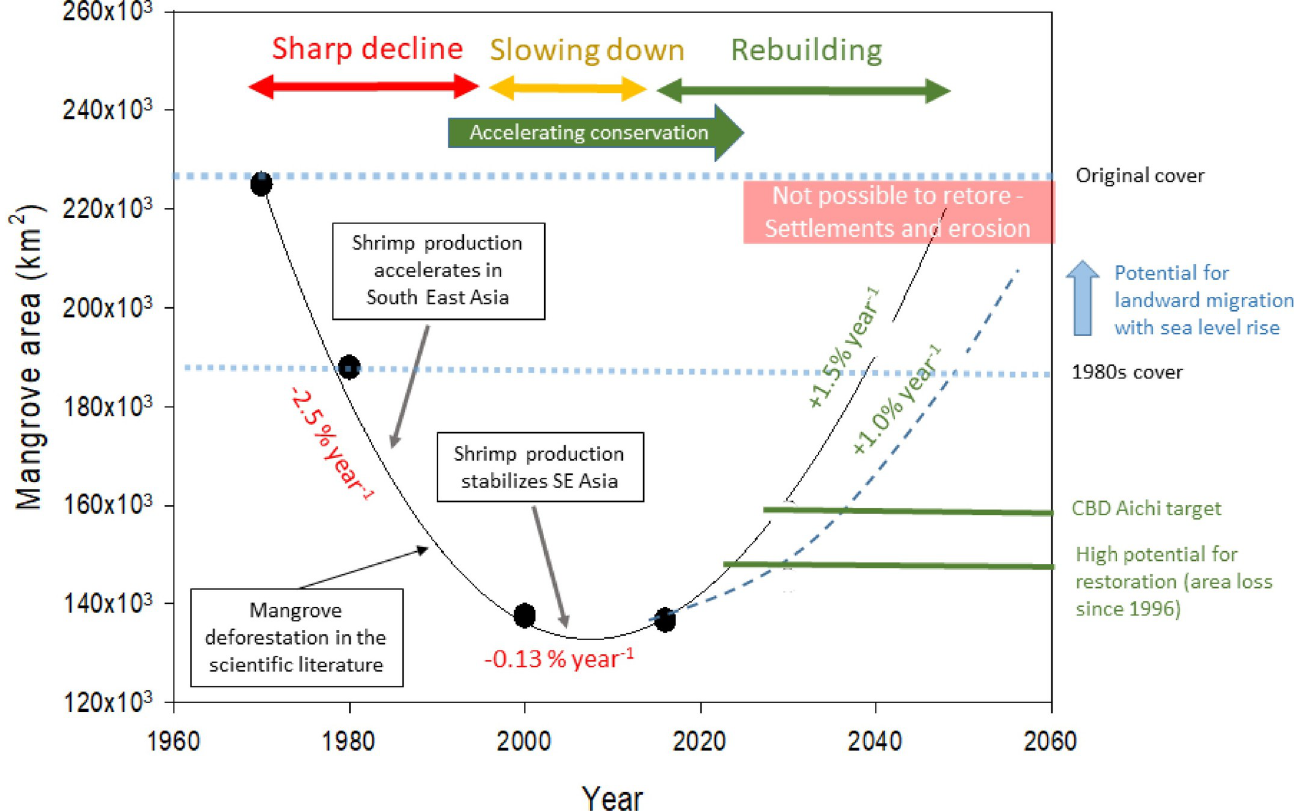
Fig 1. Global trajectories of mangrove cover show a slowdown in the rate of decline. On the right are targets and limits to recovery of mangrove cover. Restoration of approximately 1% year − 1 will lead to the recovery of high-value sites, achieve Aichi Target 15 by 2040, and return mangrove coverage to 1980s area by 2050 (dashed line). Sea level rise could increase the potential area for restoration with landward migration onto floodplains (blue arrow), while conversion to settlements and erosion will limit restoration potential (red box). Recovery to estimated historical baselines would require approximately 90,000 km 2 of coastal